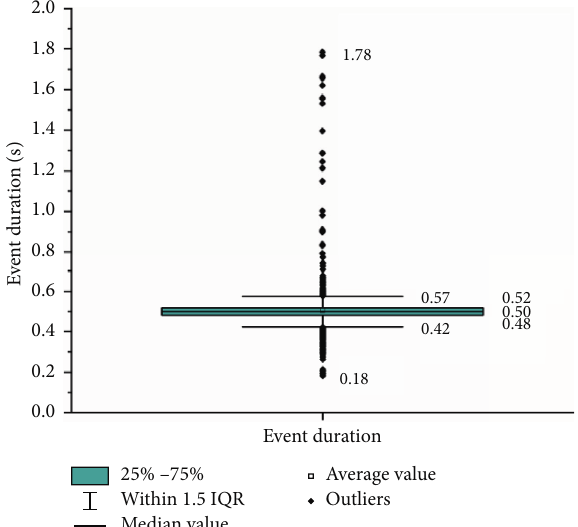
Figure 8: Box diagram of event duration.